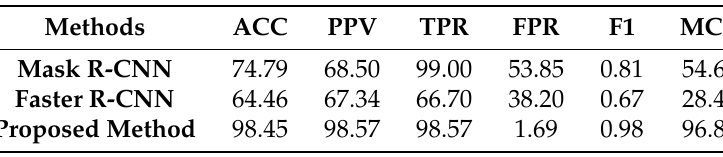
Table 4. Detection performance with different algorithms.